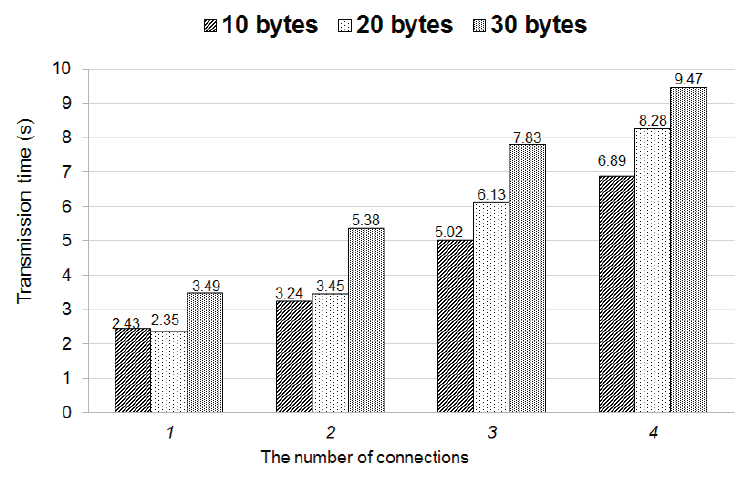
Figure 17. Estimate transmission